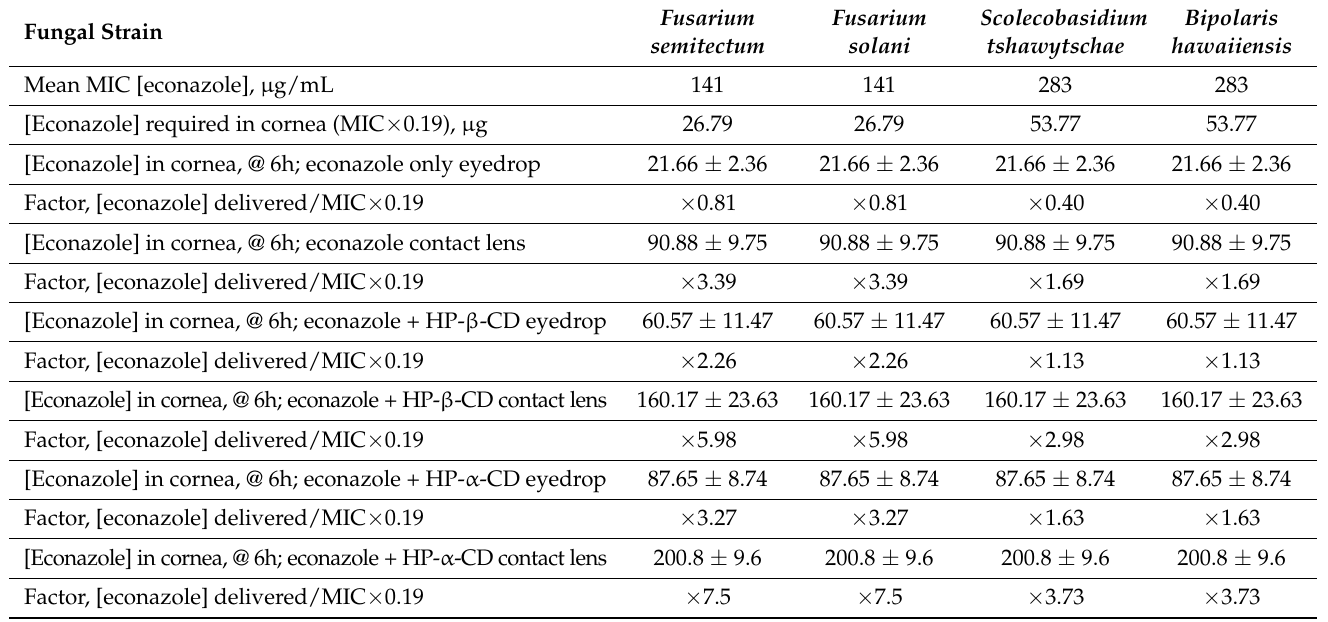
Table 2. Minimum inhibitory concentrations (MICs) of econazole against four strains associated with fungal keratitis, the concentration required in the cornea to attain MIC, the concentration of econazole localised in the cornea after 6 h ( n = 3 ± SD) and factor (based on a corneal volume of 0.19